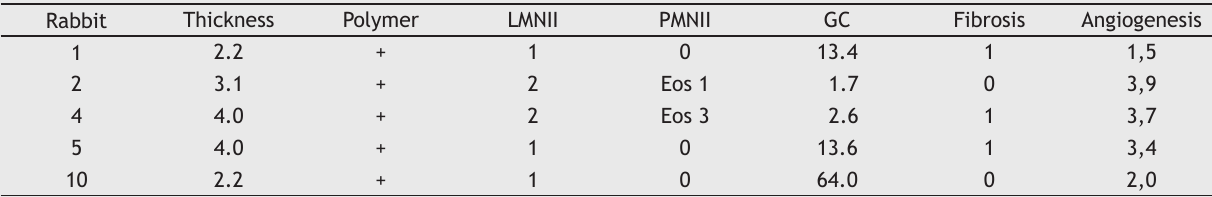
Table 1 Histological characteristics found in Group I - 21 days – Vocal fold with biopolymer. Rabbit